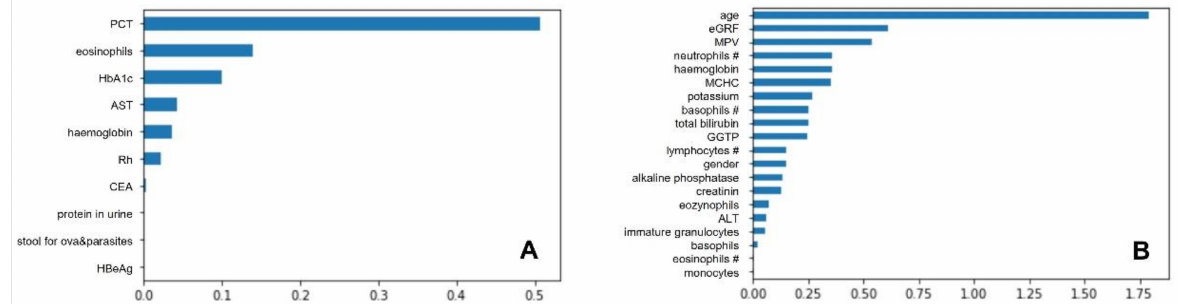
Figure 1. Logistic regression features importance for ulcerative colitis ( A ) and Crohn’s disease ( B ). Abbreviations for ( A ): PCT, plateletcrit; AST, aspartate aminotransferase; CEA, carcinoembryonic antigen; HBeAg, Hepatitis B e Antigen; abbreviations ( B ): eGFR, estimated glomerular filtration rate; MPV, mean platelet volume; MCHC, mean corpuscular haemoglobin concentration; GGTP, gamma-glutamyl transpeptidase; ALT, alanine